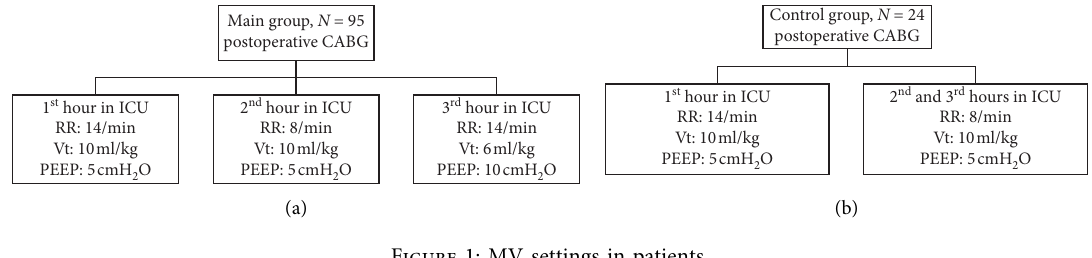
Figure 1: MV settings in